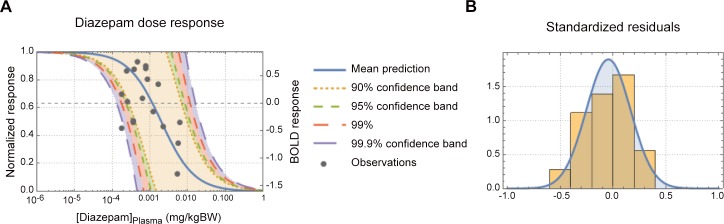
DZ dose-response curve.(A) Panel A shows the predicted diazepam-dose-fMRI response curve. The normalized response is shown on the left y-axis and the actual BOLD response on the right y-axis. The mean prediction and a range of prediction confidence bands are also shown in panel A. (B) Panel B shows the standardized residual of the model fit.